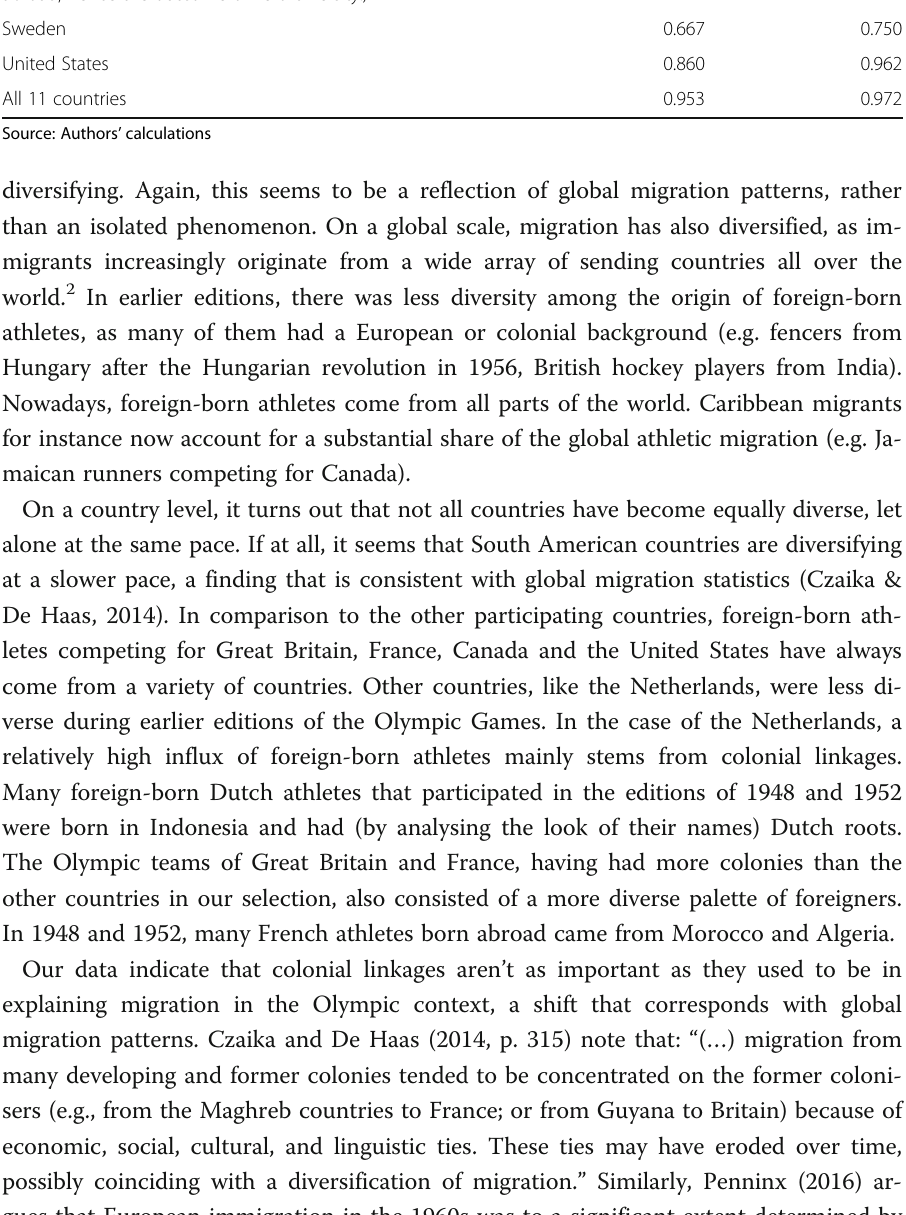
Spain (In 1960, only one athlete competing for Spain was born abroad, hence the outcome of zero